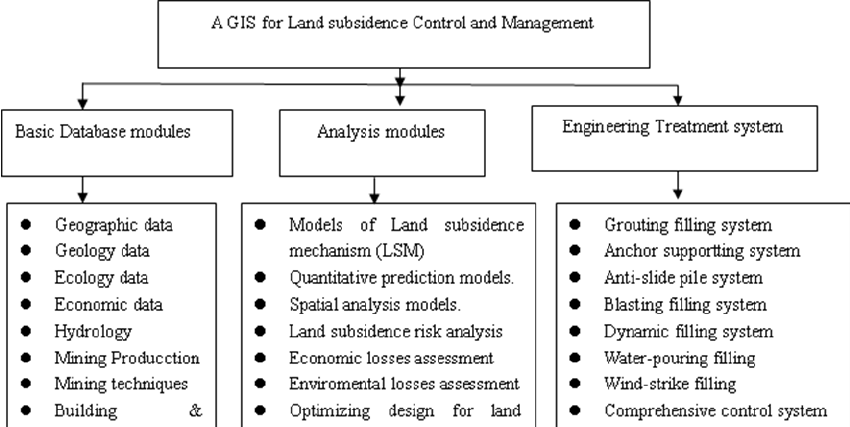
Figure 5. A GIS focussed land subsidence management system for in mined-out regions.